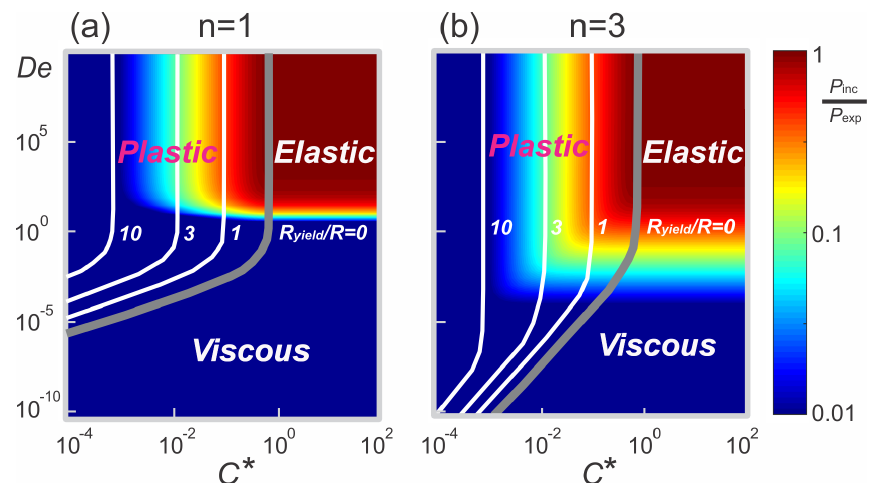
Figure 2. Inclusion pressure as a function of the Deborah number and dimensionless yield strength given different stress exponents. The contours denote the radius of plastic yield region R yield scaled by inclusion radius. The thick grey contour represents the onset of plastic yield. Three regimes are labelled: (1) elastic ( De > 1, C ∗ > 1); (2) viscous ( De < 1 and C ∗ is above the onset of plastic yield); (3) plastic ( C ∗ < 1, De is above the onset of plastic yield). To obtain the results, a residual pressure is prescribed at the beginning and the confining pressure and temperature are fixed, i.e. no temporal variations in P – T conditions.